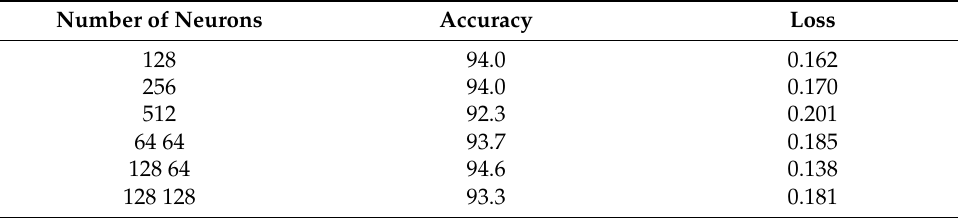
Table 5. Comparison of different neurons size in the Attention-TCN-BiGRU. Number of